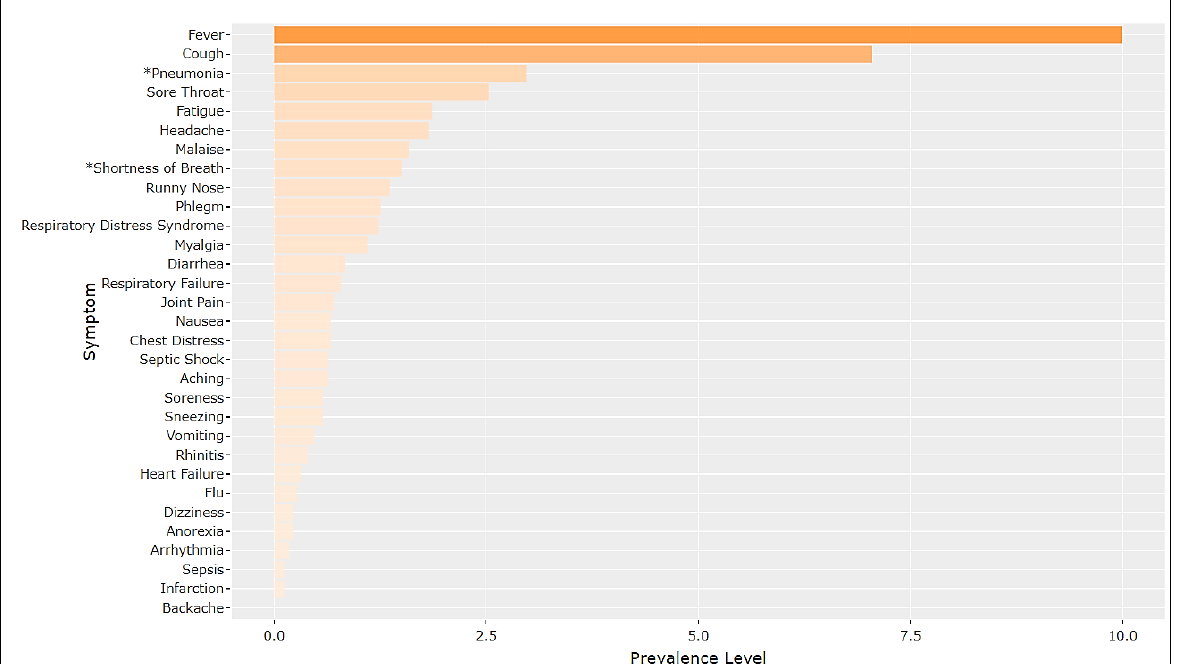
Figure 11. Common Symptoms of COVID-19